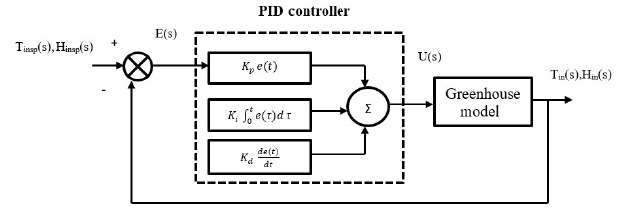
Figure 7. Closed-Loop Feedback system for Greenhouse using PID Controller.